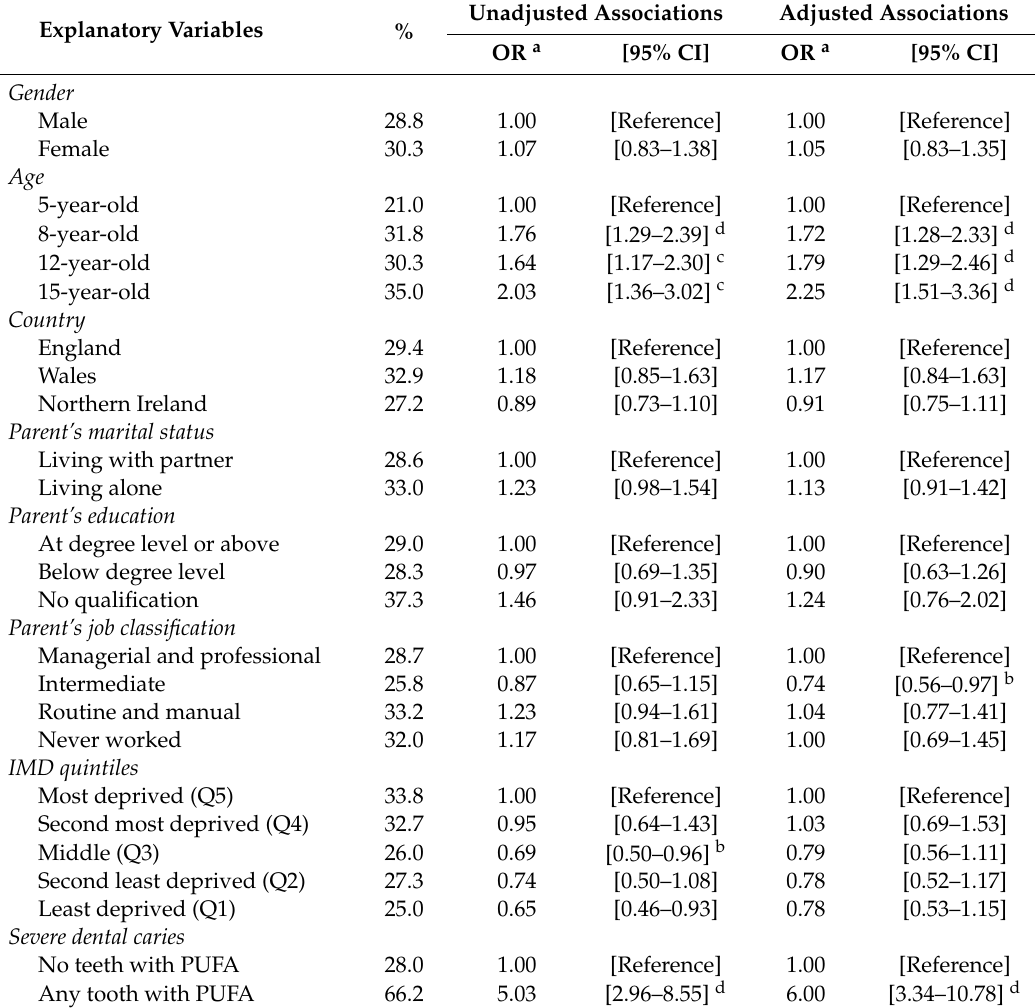
Table 2. Regression model for the association between severe dental caries (any tooth with PUFA) prevalence and any impacts on the parent’s life (n = 3879).